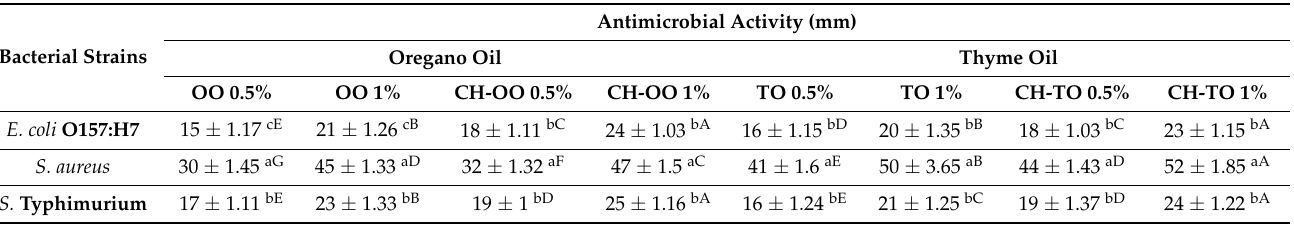
Table 2. Antibacterial activity of chitosan-based films containing oregano and thyme essential oils against foodborne pathogens (mm) (mean ±